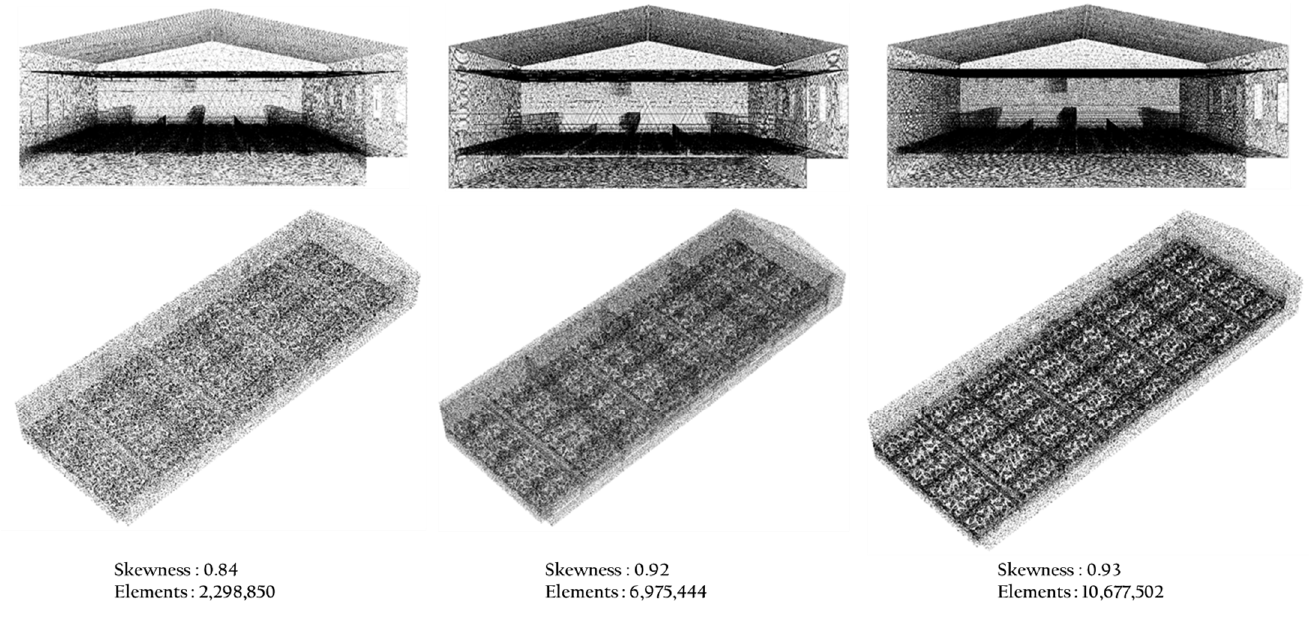
Figure 10. Results of the meshing of CFD model according to the size and number of girds.